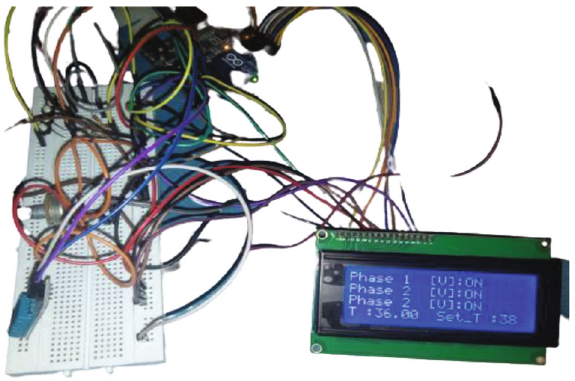
Figure 6: Real-time photos of single phasing and overtemperature protection.